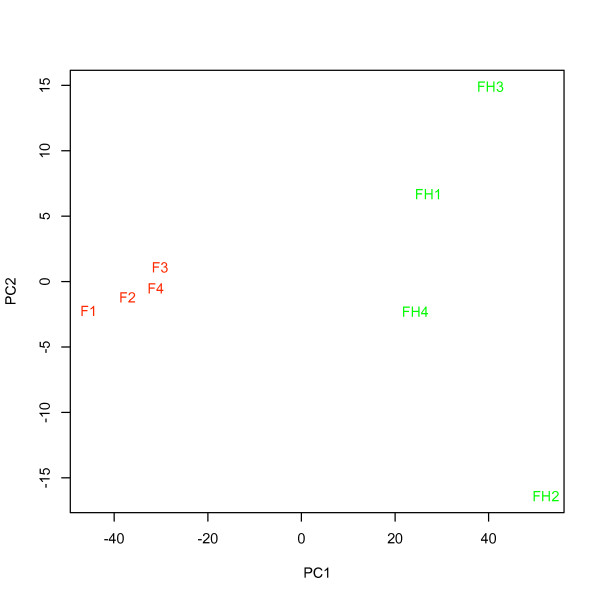
PCA for all human non-coding RNAs in hybridizations using RNA from four tumor samples labeled with both the FlashTag Biotin- and FlashTag Biotin HSR labeling kits. F (red) represents samples labeled with the FlashTag Biotin kit, and, FH (green) represents the same samples labeled with the FlashTag Biotin HSR labeling kit.